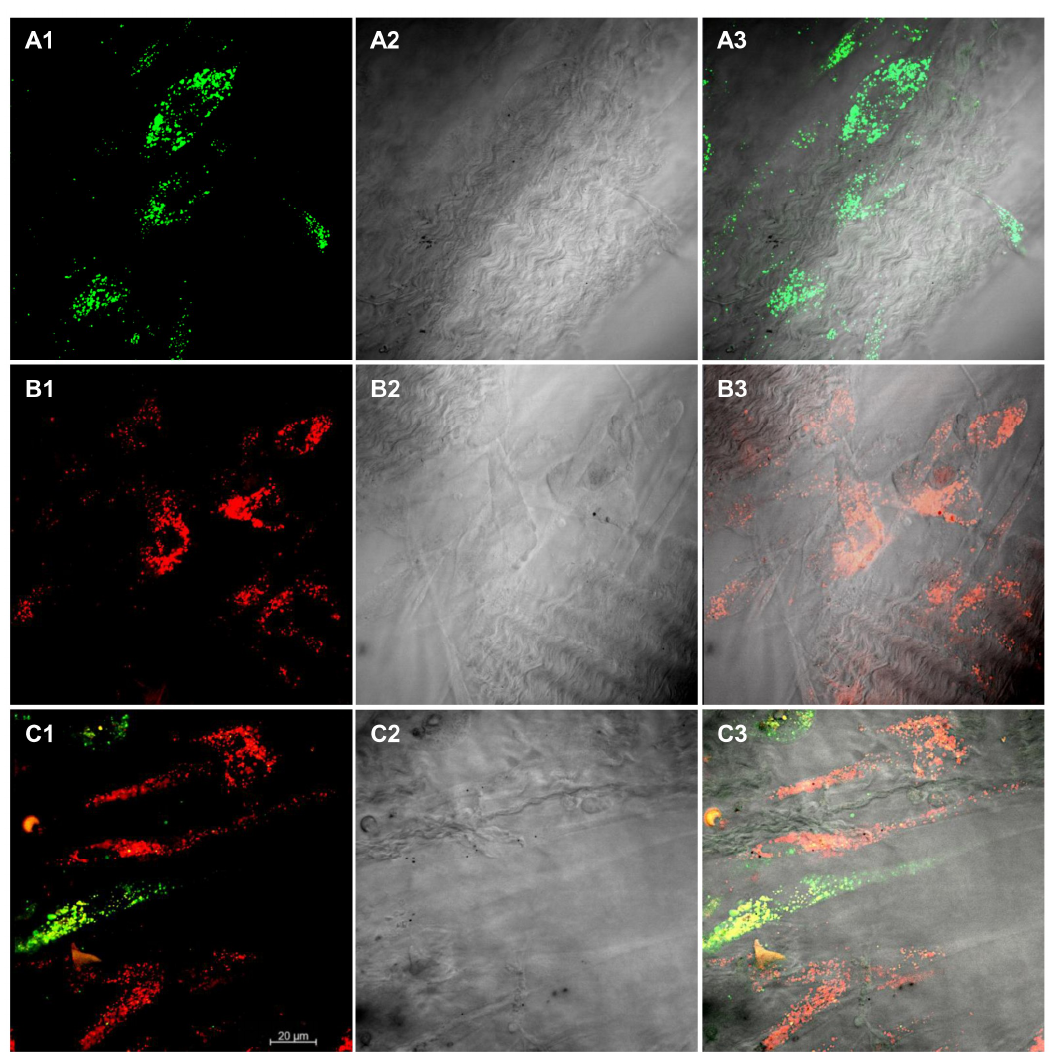
Figure 4. Cell and 3D sca ff old interaction. ( A1 ) hPDLSCs, stained with PKH67 (green fluorescence), cultured on BioR showed a fibroblast like morphology. ( A2 ) Light transmission image of BioR membrane (grey scale). ( A3 ) Merged image of above mentioned channels. ( B1 ) E-hPDLSCs, stained with PKH26 (red fluorescence), cultured on BioR. (B2 ) Light transmission image of BioR membrane (grey scale). ( B3 ) Merged image of above mentioned channels. ( C1 ) Coculture of hPDLSCs and E-hPDLSCs cultured on BioR showed the co-presence of two di ff erent cellular types with green and red fluorescence. ( C2 ) Light transmission image of BioR membrane (grey scale). ( C3 ) Merged image of above mentioned channels. Scale bar: 20 µ m; Magnification: 20 ×.